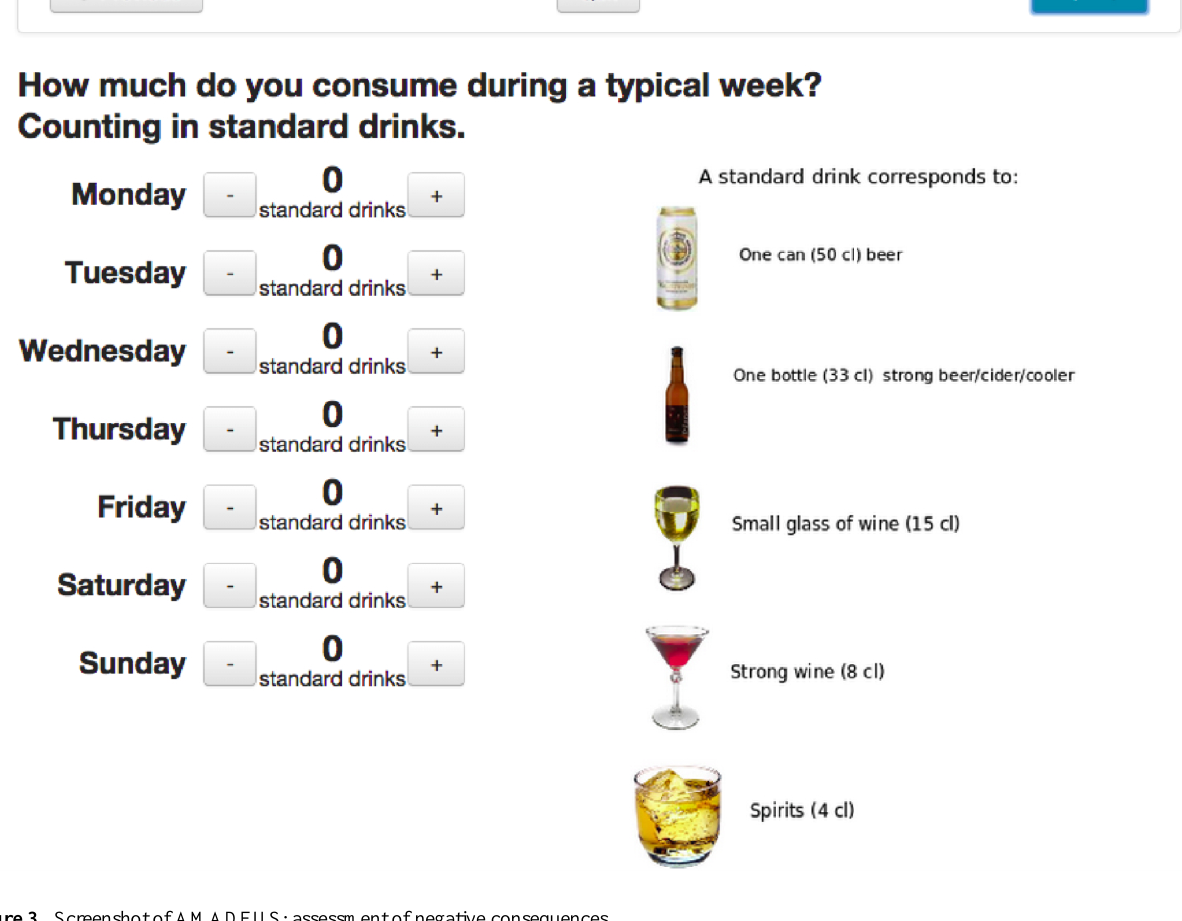
Figure 3. Screenshot of AMADEUS: assessment of negative